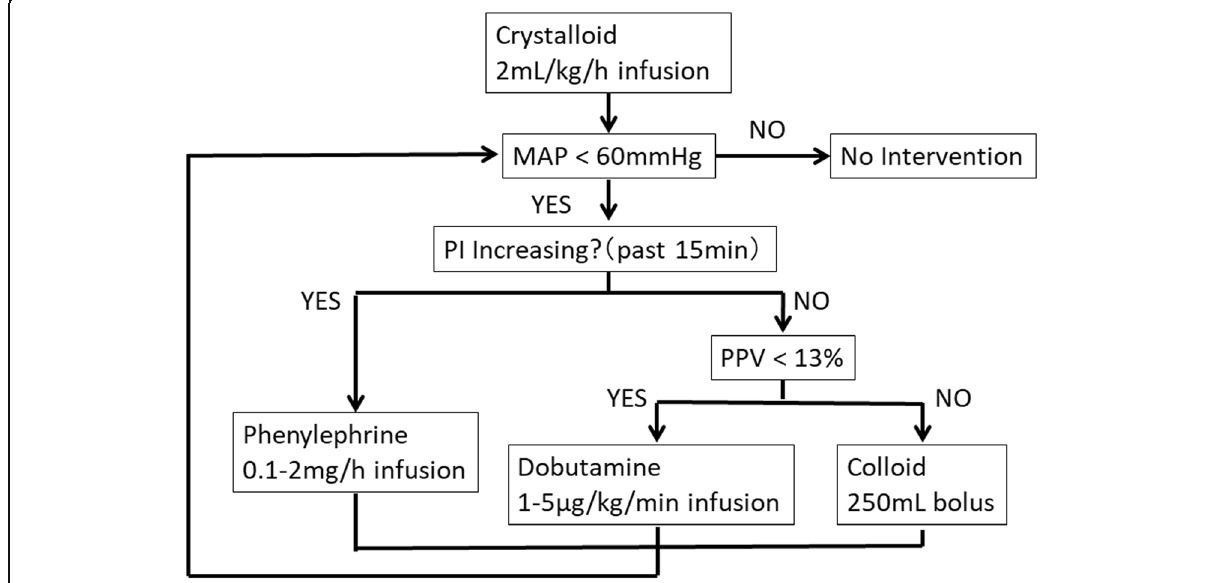
Fig. 1 Hemodynamic management protocol using the trend of the perfusion index and pulse pressure variation. Abbreviations: MAP, mean arterial pressure; PI, perfusion index; PPV, pulse pressure